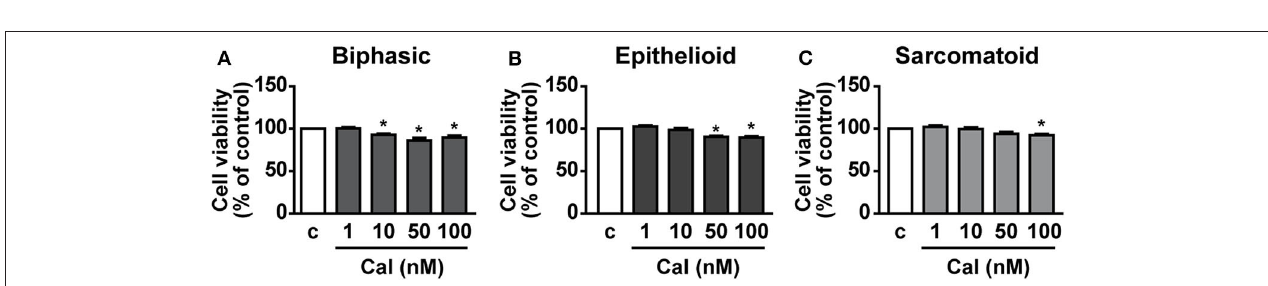
FIGURE 6 | Inhibitory effects of calcitriol in primary MPM cells. Cell viability (MTT assay) in biphasic (A) , epithelioid (B) , and sarcomatoid (C) primary MPM cells cultured in serum-deprived medium (c, control) for 12h, then treated for 24h with calcitriol (Cal), at the concentrations indicated. Results, expressed as percent of control, are means ± SEM. * P < 0.05 vs. c; n =